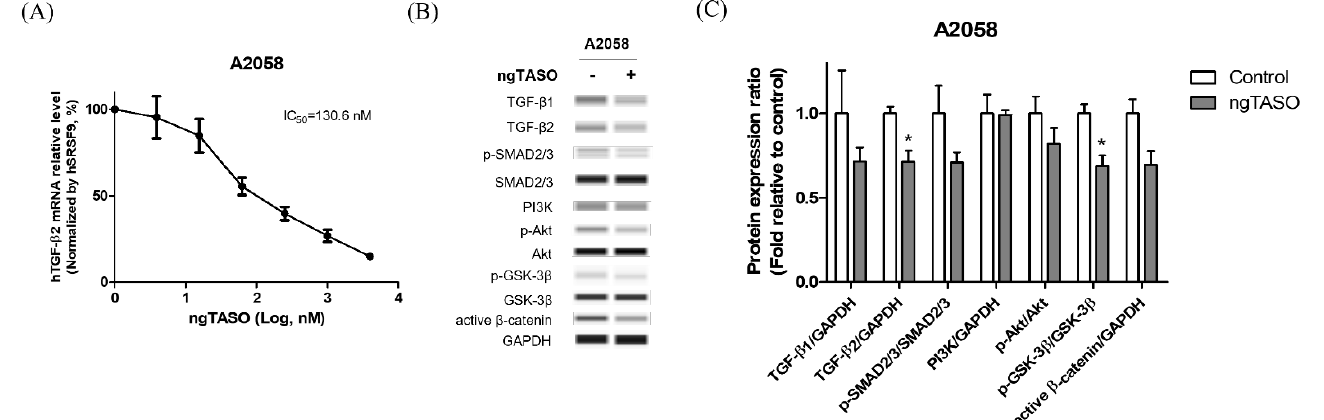
Figure 1. Effects of ngTASO on TGF- β 2 production and its associated downstream signaling in A2058 cells. Alteration of TGF- β -associated downstream signaling was measured. ( A ) TGF- β 2 mRNA expression levels were measured by qRT-PCR and normalized to SRSF9 expression. ( B ) Representative Western blot band images and ( C ) relative intensity ratios of each protein expression in A2058 were presented. Data are expressed as means ± S.D. from triplicate wells. * p < 0.05 vs. control group (Student t -test).